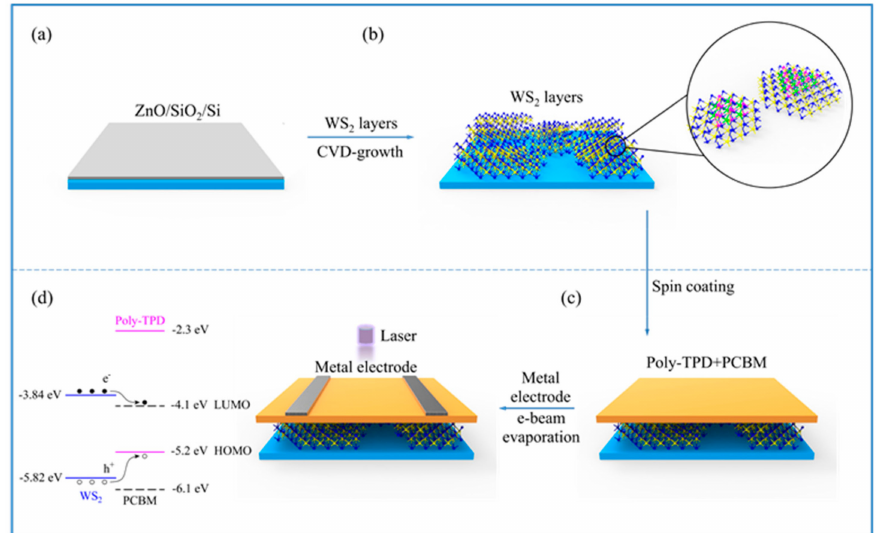
Figure 1. Illustration (color online) of the fabrication procedure of the photodetector based on the organic semiconductor / inorganic tungsten disulfide (WS 2 ) heterojunction. ( a ) The silicon substrate with ZnO and SiO 2 film (ZnO / SiO 2 / Si). ( b ) Two-dimensional (2D) WS 2 growth on the surface of SiO 2 / Si through a chemical vapor deposition (CVD) method. During the growth of the WS 2 , ZnO was removed from the SiO 2 / Si. ( c ) (Poly-( N , N (cid:48) -bis-4-butylphenyl- N , N (cid:48) -bisphenyl) benzidine and